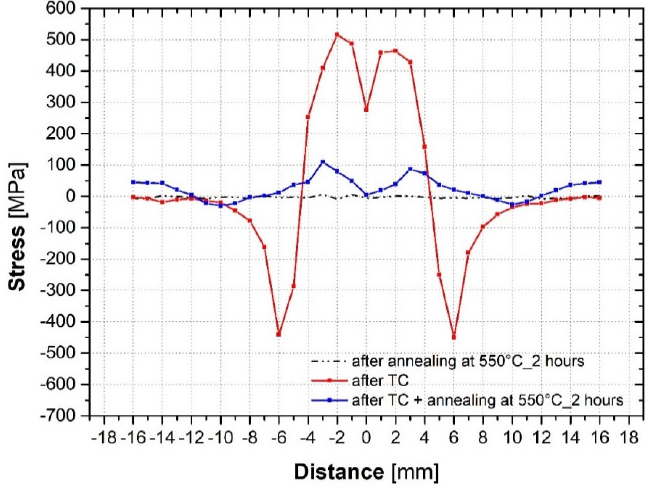
Figure 10. Courses of residual stresses after application of temperature cycles (red curve) and after annealing to reduce residual stresses (blue curve).